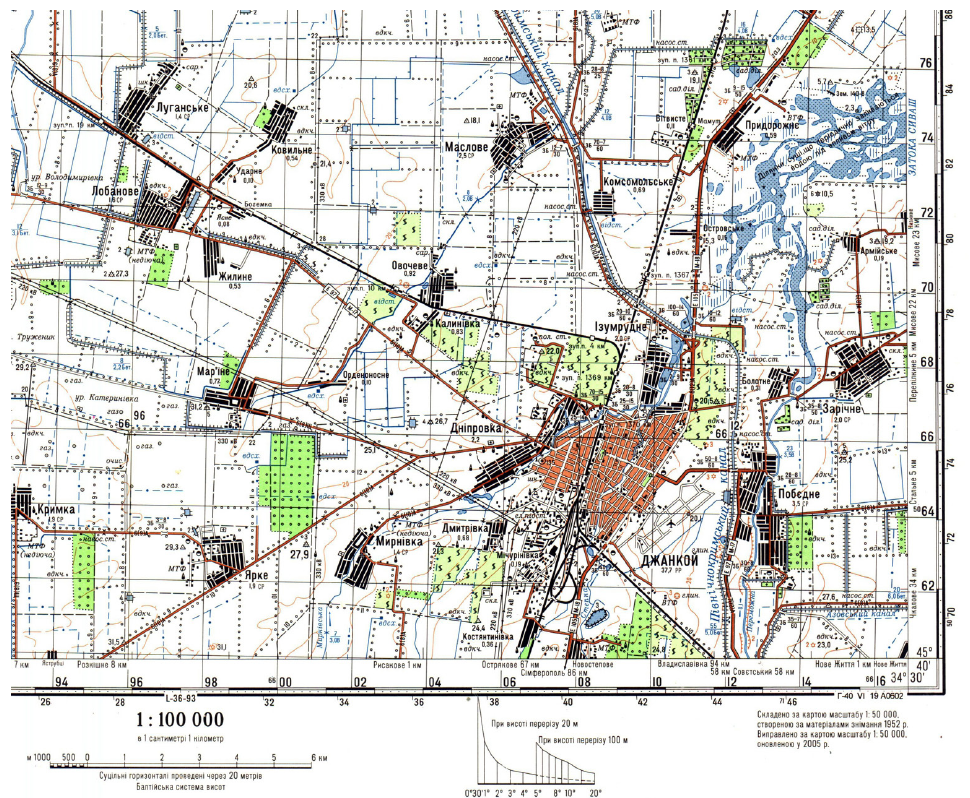
Fig. 3. A part of the nationwide 1:100,000 scale topographic